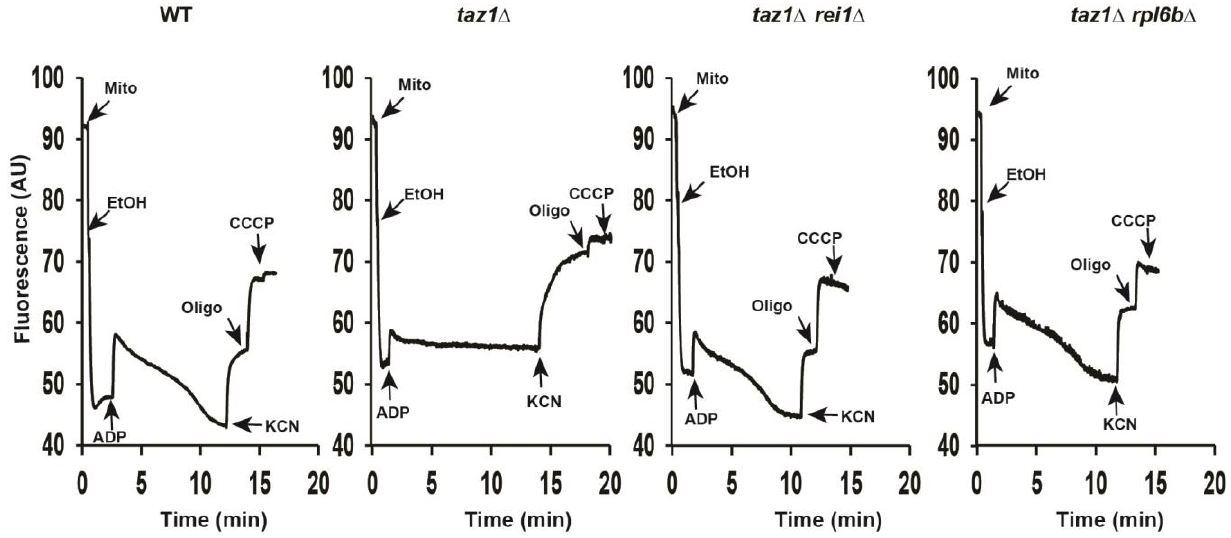
FIGURE 4: Mitochondrial membrane potential. Variations in mitochondrial ΔΨ were monitored by fluorescence quenching of Rhodamine 123, using intact, osmotically-protected, mitochondria isolated from WT, taz1 Δ, taz1 Δ rei1 Δ and taz1 Δ rpl6b Δ cells grown in CSM containing 0.5% galactose + 2% ethanol at 36°C until a density of 2-3 OD 600nm . The additions were 75 μM ADP, 0.5 μg/ml Rhodamine 123, 75 μg/ml mi- tochondrial proteins (Mito), 10 μl ethanol (EtOH), 2 mM potassium cyanide (KCN), 4 μM CCCP (carbonyl cyanide-m-chlorophenyl hydrazone) and 4 μg/ml oligomycin (oligo). The shown tracings are representative of four experimental trials. The data for WT and taz1 Δ strains were reported previously